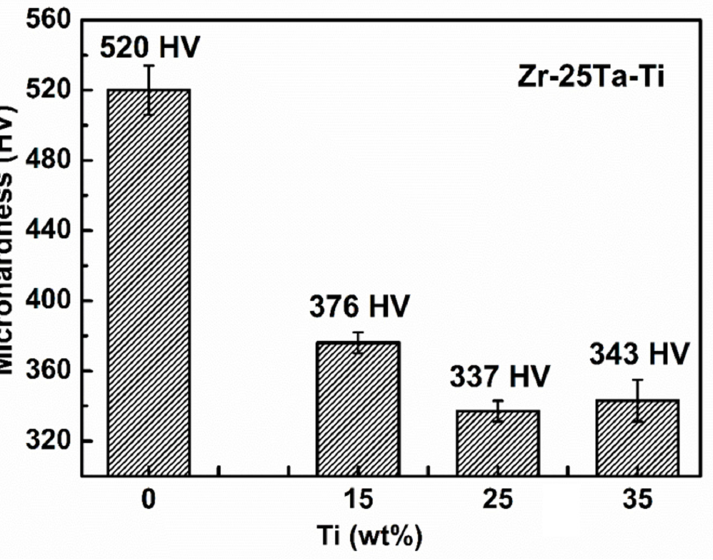
Figure 5. Vickers microhardness as a function of titanium concentration for all Zr-25Ta-xTi alloys used in this study.